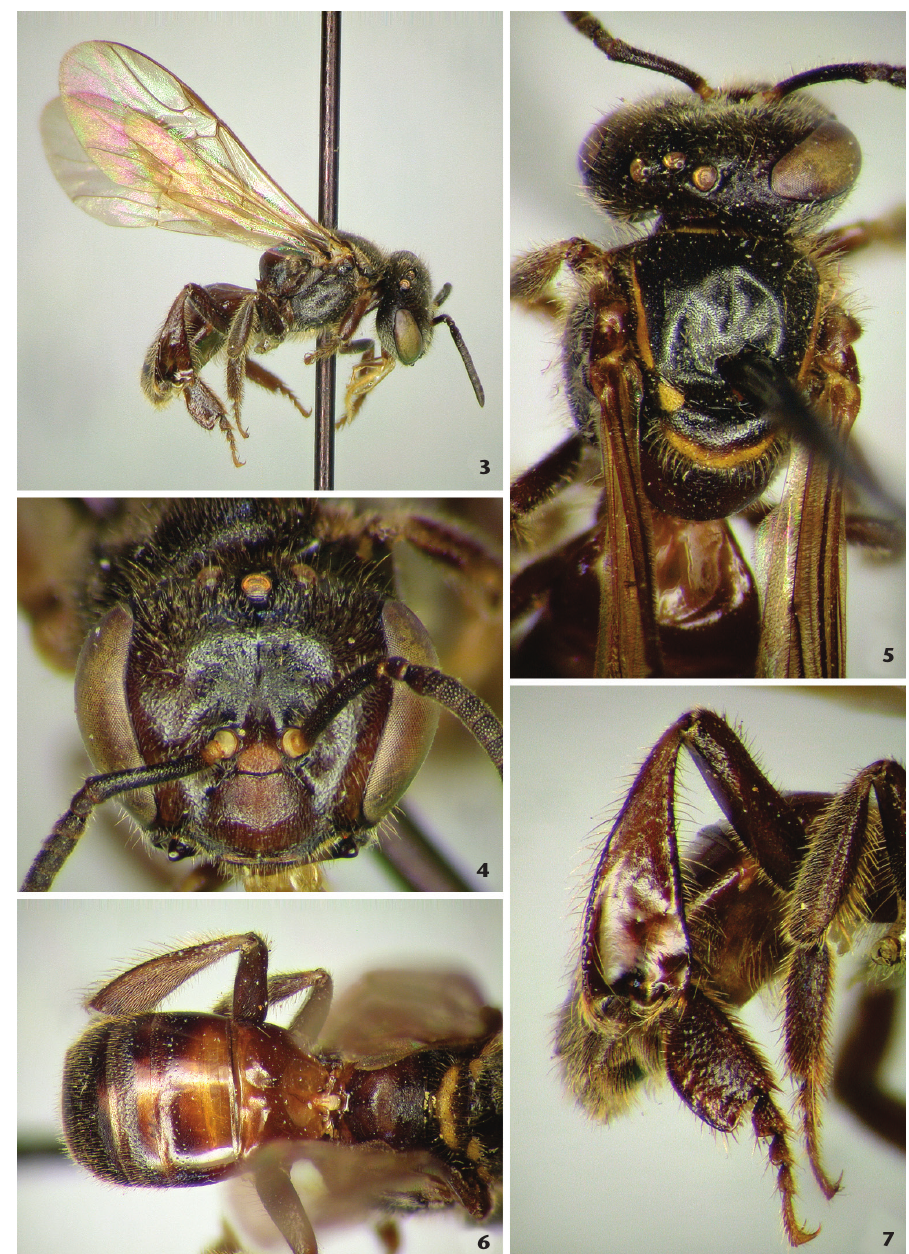
Figures 3-7. Holotype worker of Trigona nigrifacies Friese, 1900: (3) habitus, side view; (4) head, frontal view; (5) head and mesosoma, dorsal view; (6) metasoma, dorsal view; (7) hind leg, side side of mesoscutum, axilla, distal margin of scutellum, apex of mesepisternum; in addition, with a fine shorter pilosity, of fore femur and basis of all tibiae. e) Vestiture: erect hairs on covering the face, gena, mesoscutum, lateral mesepisternum, body uniformly pale-yellow to light brown, darker on inner metepisternum and propodeum laterally, mostly erect, except surface of tarsi, mostly simple, except on pronotal lobe, tegula, for gena, mostly simple on clypeus and mesoscutum, and finely anterior margin of mesoscutum and along anterior portion branched on remainder; metapostnotum glabrous; labial palpi ZOOLOGIA 33(1): e20150153 | DOI: 10.1590/S1984-4689zool-20150153 3 / 8